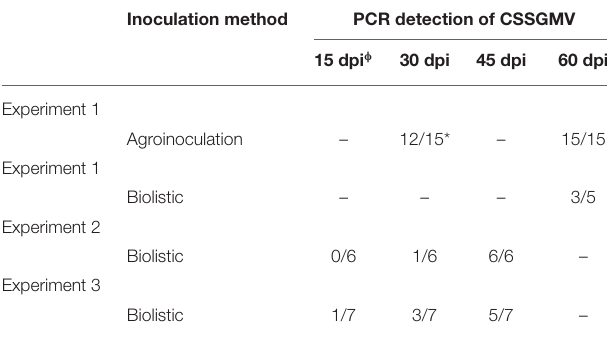
TABLE 2 | Infectivity tests of the cacao swollen shoot Ghana M virus (CSSGMV) infectious clone in cacao “Amelonado”